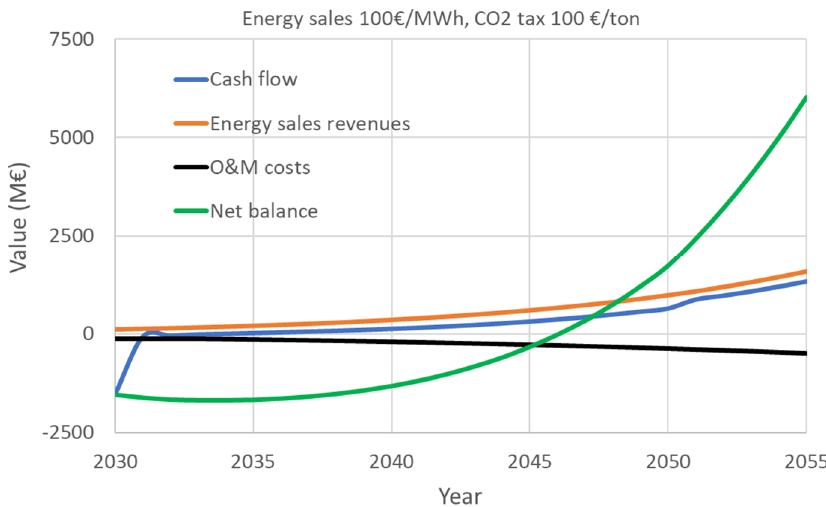
Figure 8. Cash flow analysis for the reference case with electricity purchase of 100 EUR/MWh, and a CO 2 trade cost of 100 EUR/ton and surplus electricity at 0 EUR/MWh.